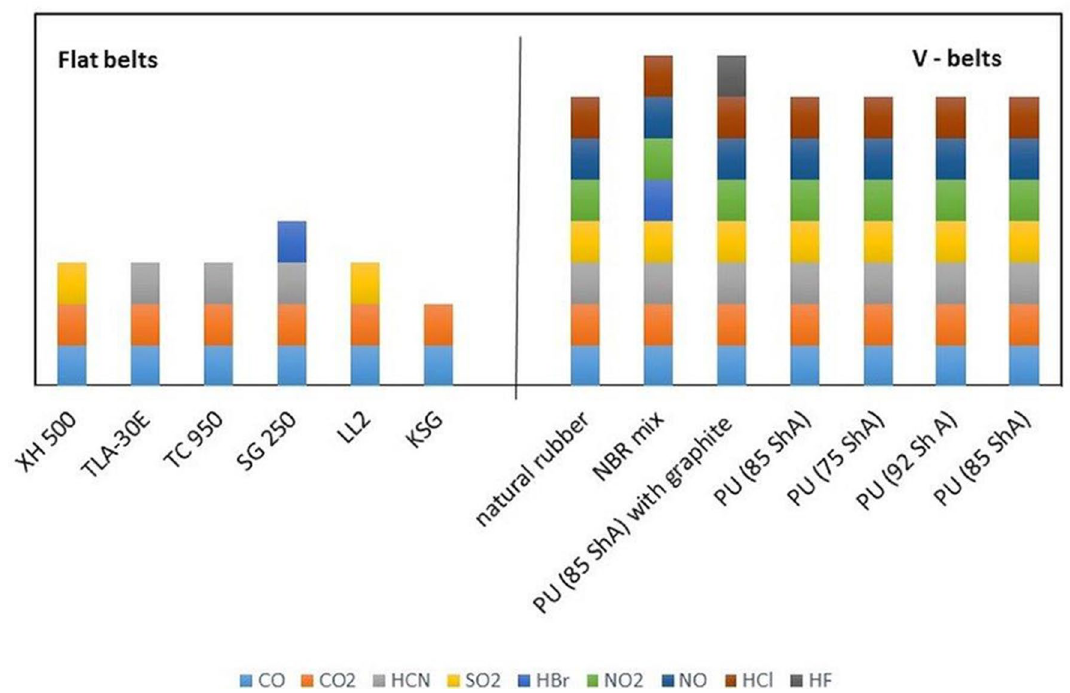
Figure 9. Qualitative comparison of the toxins emitted during thermal decomposition and combustion of flat belts and